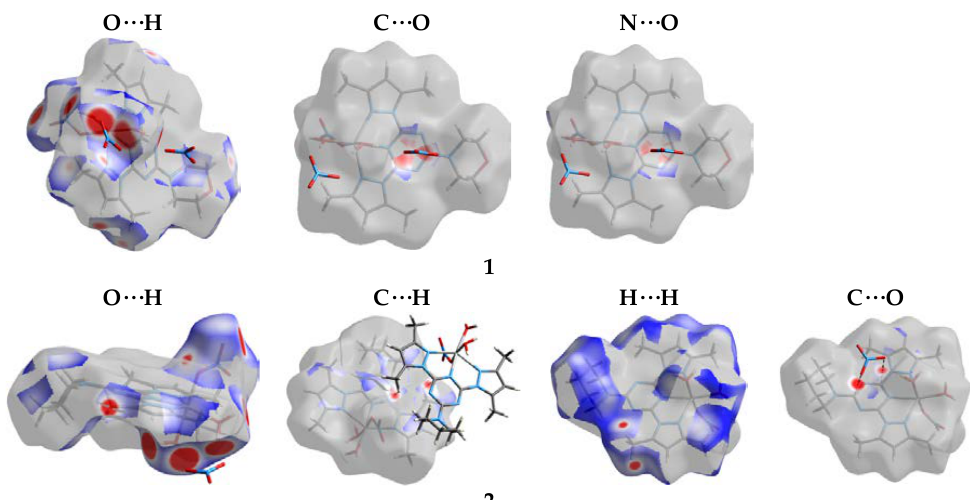
Figure 5. Summary of the intermolecular interactions in 1 and 2 . Table 5. Atoms in molecules (AIM) indices (a.u.) for the Mn–O and Mn–N bonds.